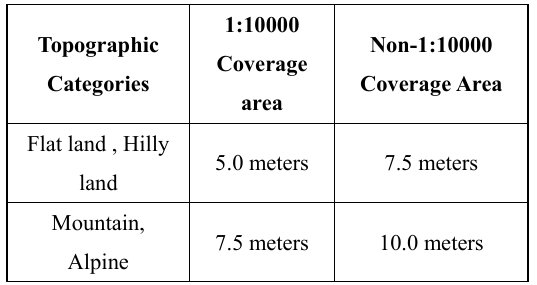
Table 1. Plane Accuracy of 1:10000 Orthophoto Image